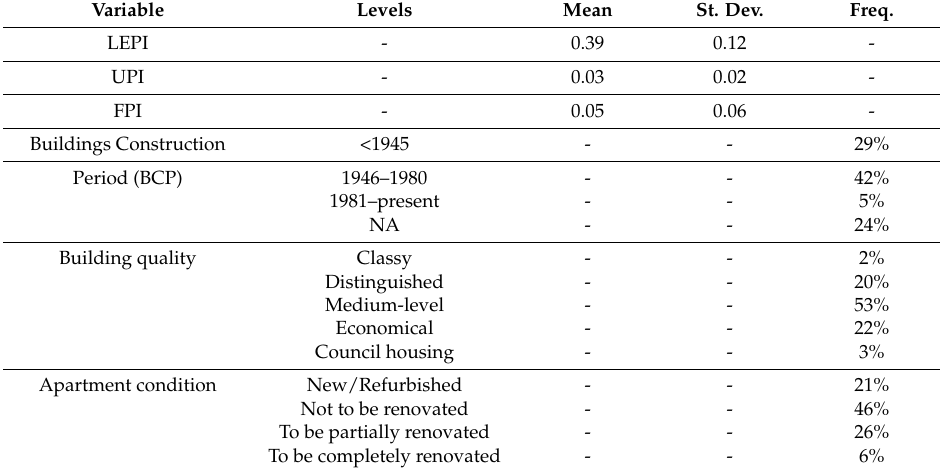
Table 2. Descriptive statistics of the Turin property prices sample: the dependent variable Listing Price (LP), characteristics of buildings and apartments (Source: Authors’ elaboration on TREMO